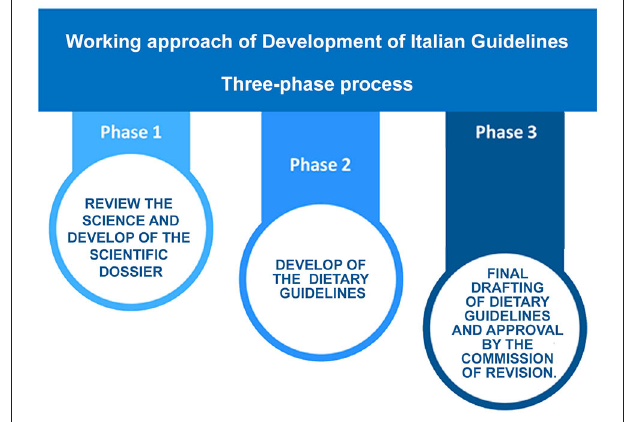
FIGURE 3 | Working approach of development of the